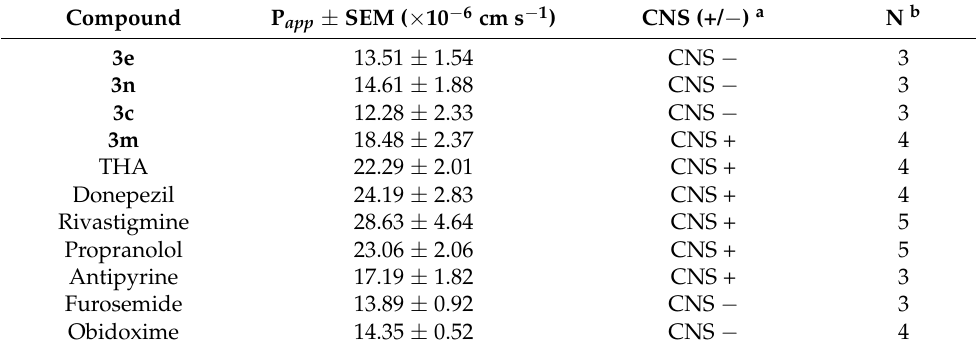
Table 6. Prediction of the BBB penetration of drugs expressed as the apparent permeability coefficient (P app ) ± SEM.